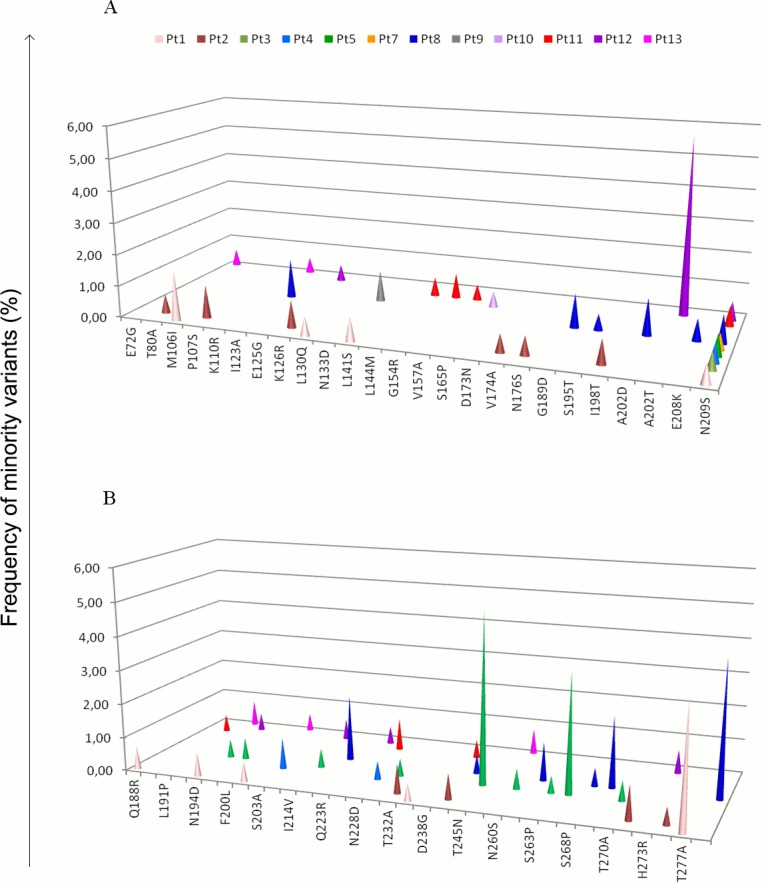
Frequency of minority variants of HA (panel A) and NS1 (panel B) proteins in influenza A(H1N1)pdm09 virus present in the nasopharyngeal swabs of 12 out of 13 patients of the study. Each patient is identified by a color code. The amino acid positions are referred to A/California/07/2009(H1N1), adopted as reference for this analysis (H1 numbering excluding the signal peptide).